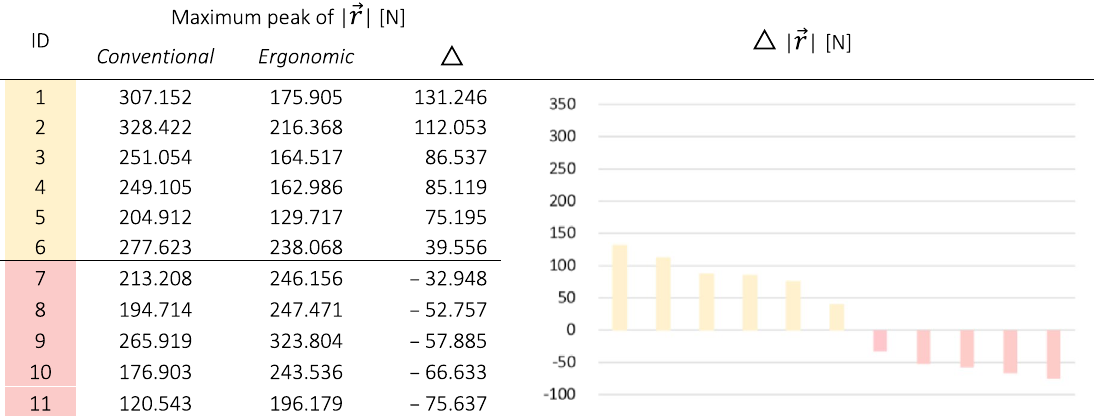
Table 2. Maximum peak of the resultant ground reaction force vector ( | conventional and ergonomic transfer. The deviation ( △ ) between these tasks is visualized for each participant and group classification (right).